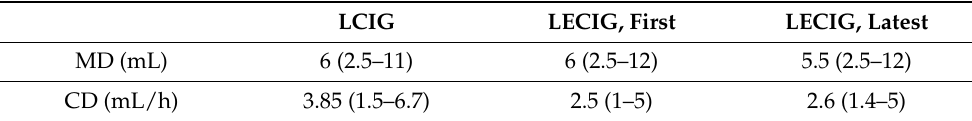
Table 5. Comparison between levodopa–carbidopa intestinal gel (LCIG) and LECIG (first and latest) dosage ( n =